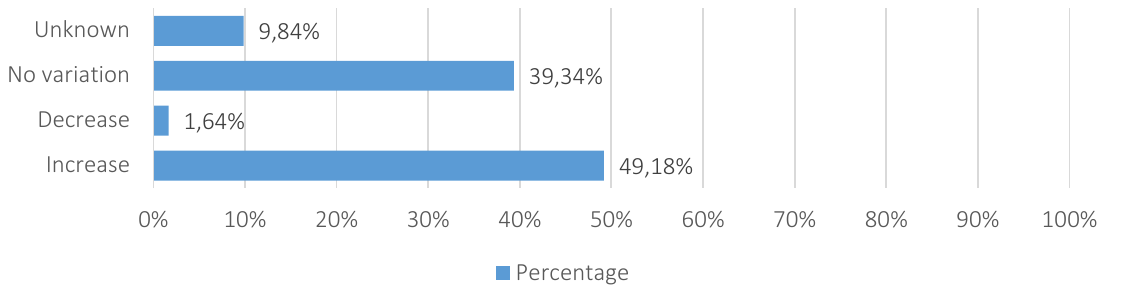
Figure 4. The future trend perception of catastrophic